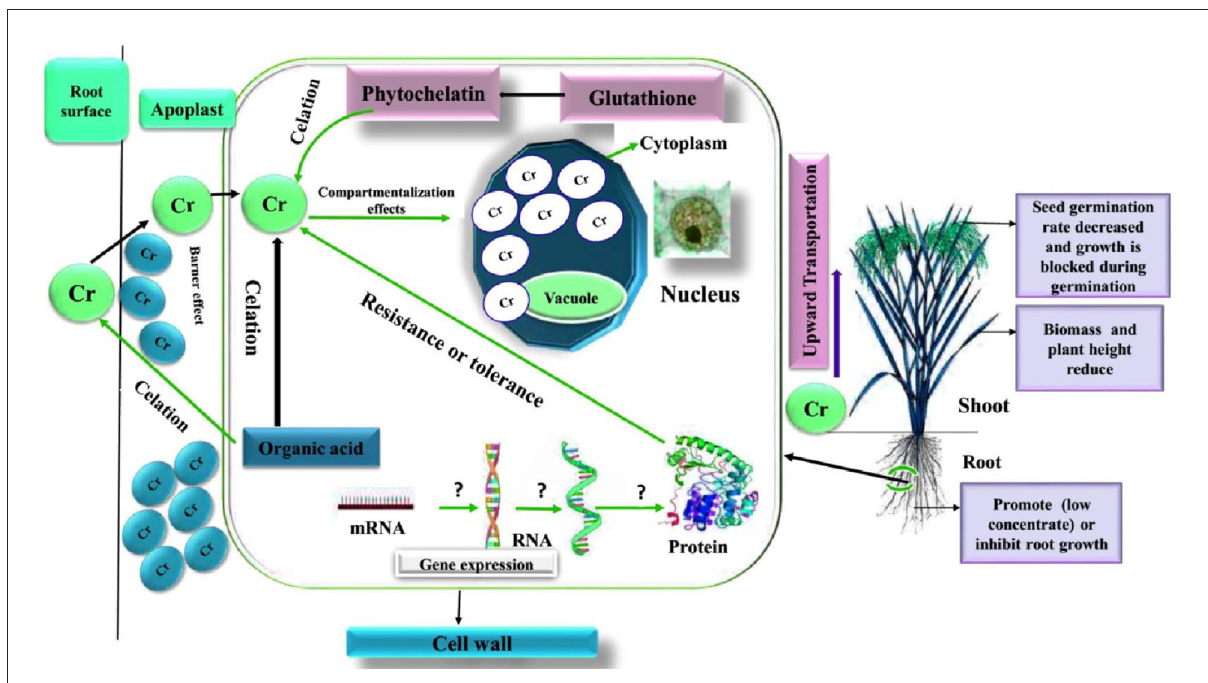
FIGURE3 Schematic diagram of the influence of heavy metal chromium on plant growth, physiology, and molecular regulation (Shanker et al., 2005).